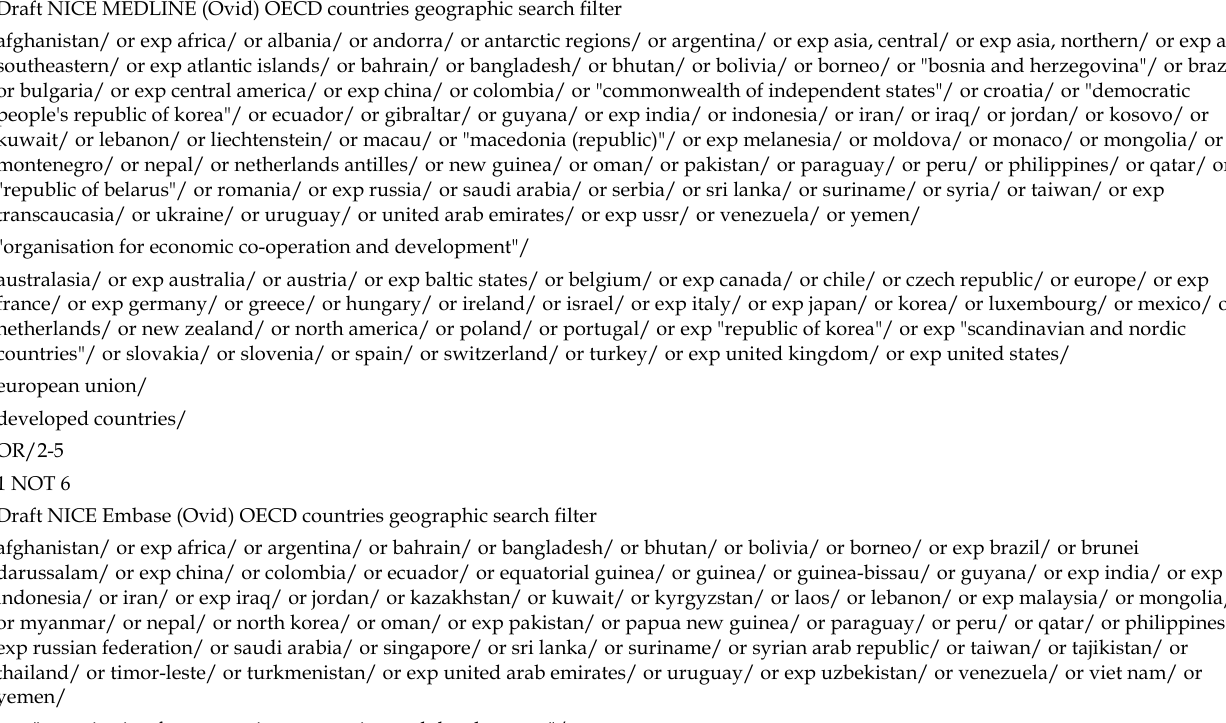
Figure 3 Draft NICE OECD countries geographic search filters Draft NICE MEDLINE (Ovid) OECD countries geographic search filter